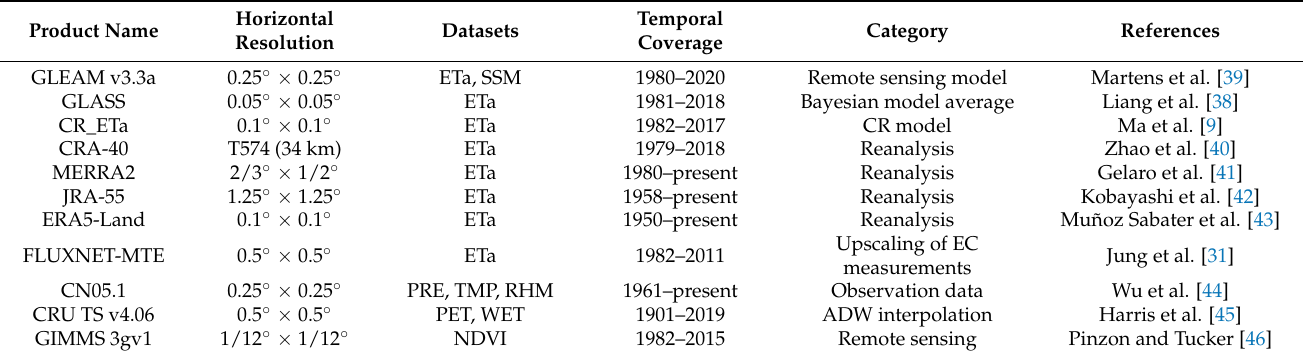
Table 1. Details of the multi-source products used in this